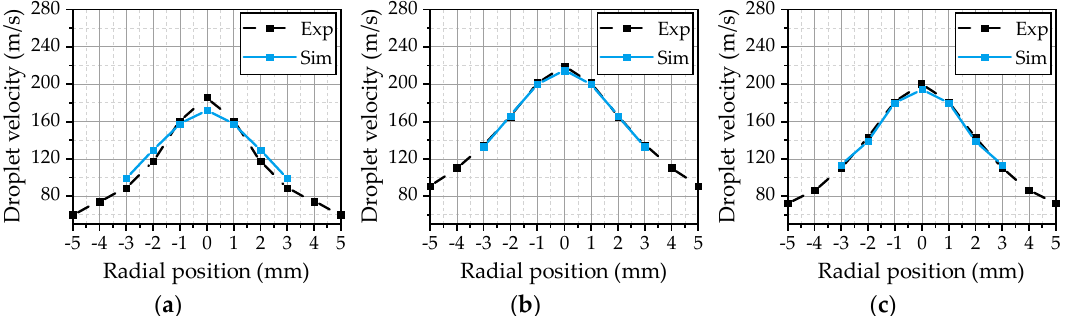
Figure 8. Simulated and measured radial velocity profiles of droplets with a diameter of 5 µ m for OP 1 ( a ), OP 2 ( b ) and OP 3 ( c ).